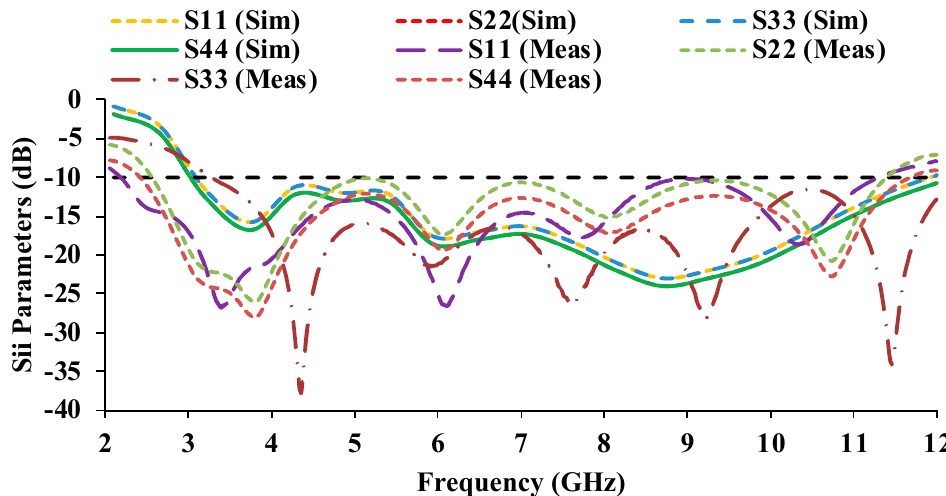
Figure 10. Simulated and measured reflection coefficient plots of the MIMO antenna.